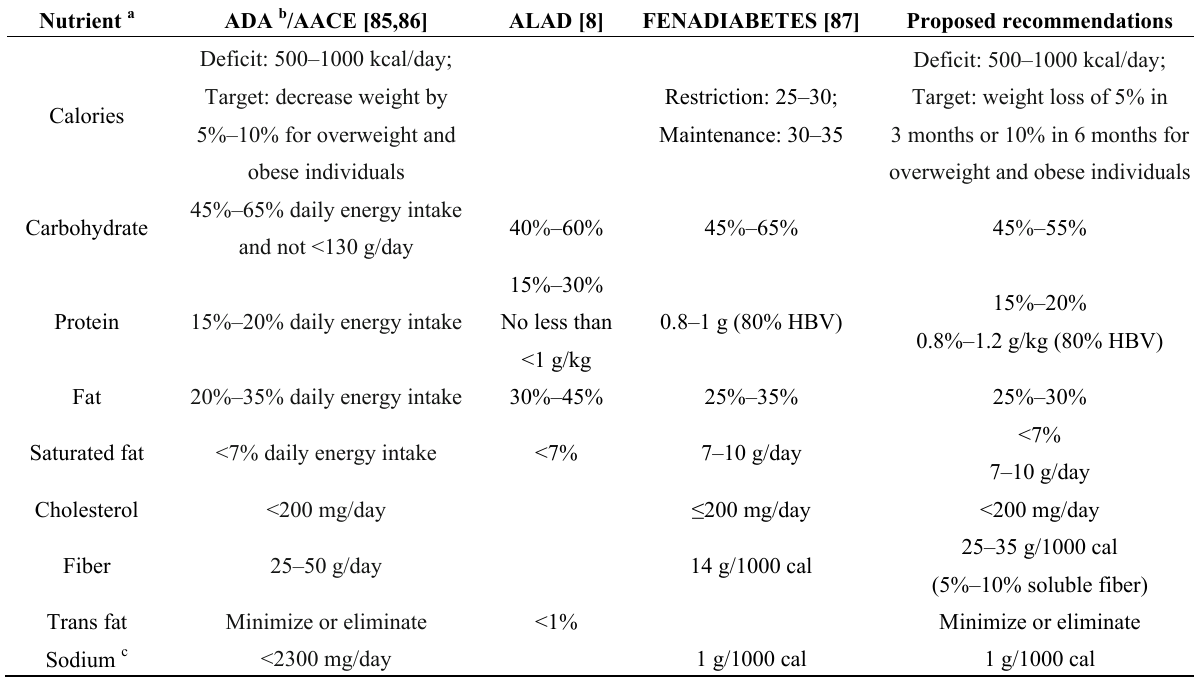
Table 5. ADA/AACE, ALAD, FENADIABETES and proposed major nutrition recommendations for